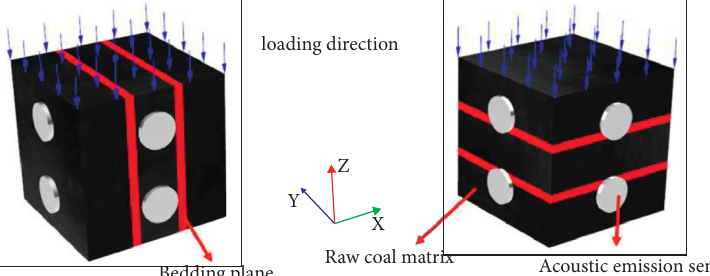
Figure 2: Loading diagram of sample and arrangement of acoustic emission sensor. (a) Axial parallel bedding loading. (b) Axial vertical bedding loading.